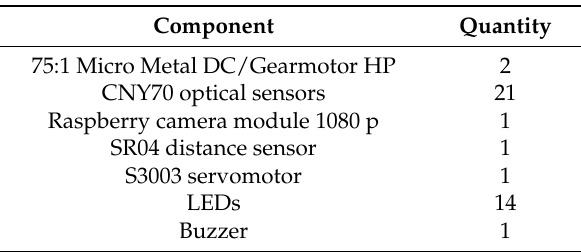
Table 2. Accessible components of the